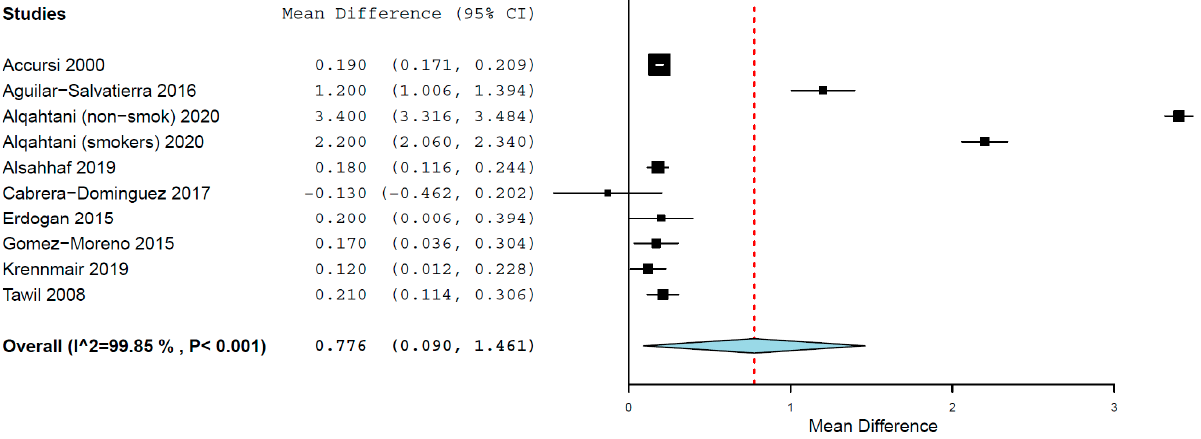
Figure 6. Forest plot for the event ‘marginal bone loss’.